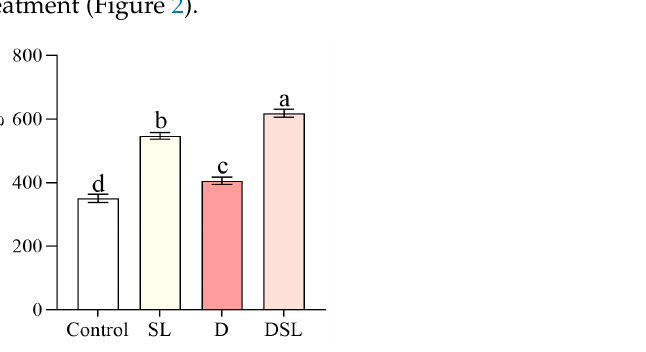
Figure 2. SL content of alfalfa root in response to different treatments. Results are presented as the mean of four independent experiments ± standard error. a–d Different superscripts mark significant mean of four independent experiments ± standard error. a − d Different superscripts mark significant differences between the treatments ( p < differences between the treatments ( p < 0.05).